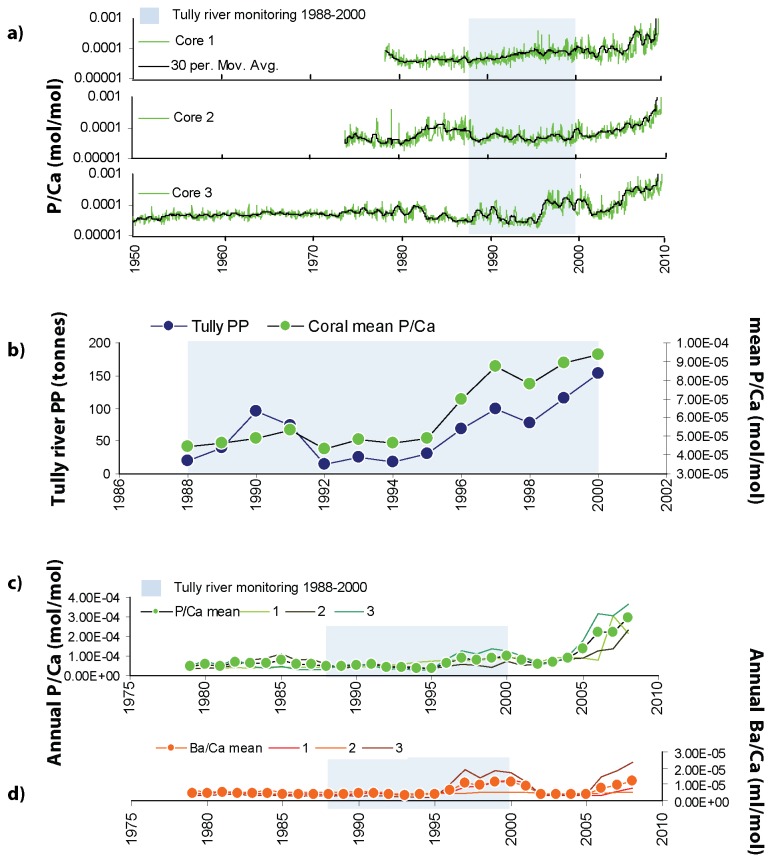
Time series detailing (a) fine resolution P/Ca (log scale, mol mol-1) records from 3 individual Dunk Island coral cores, (b) mean annual records for: P/Ca coral cores (n=3) and Tully River particulate phosphorus loads.Annual trace element records from each core (numbered 1 to 3) and annual mean values (n=3 cores) for (c) P/Ca (phosphorus proxy), and d) Ba/Ca (sediment proxy). Note: data from the live coral tissue zone have not been included. Blue boxes highlight the discrete 13 year period of contemporaneous river monitoring data.